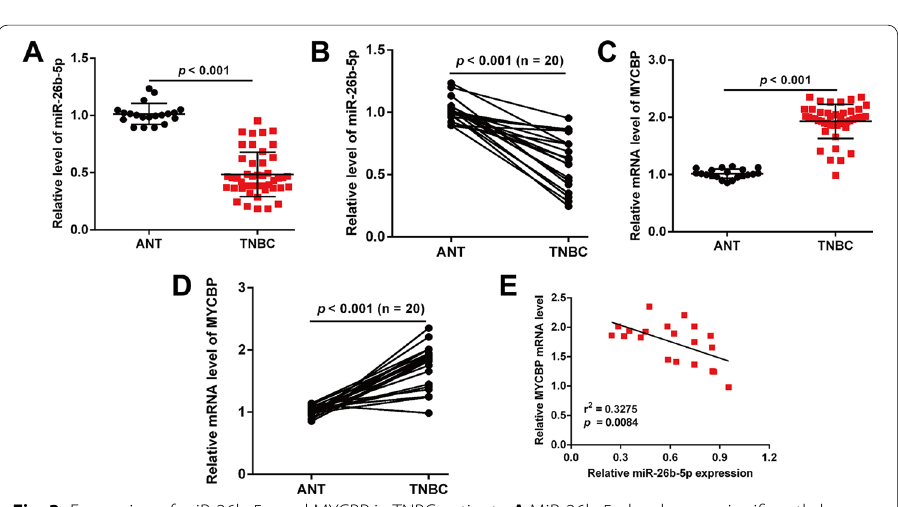
and BT-549 cells. These results suggested that miR-26b-5p negatively regulated the expression of MYCBP through its 3 ′ UTR region binding sequence.